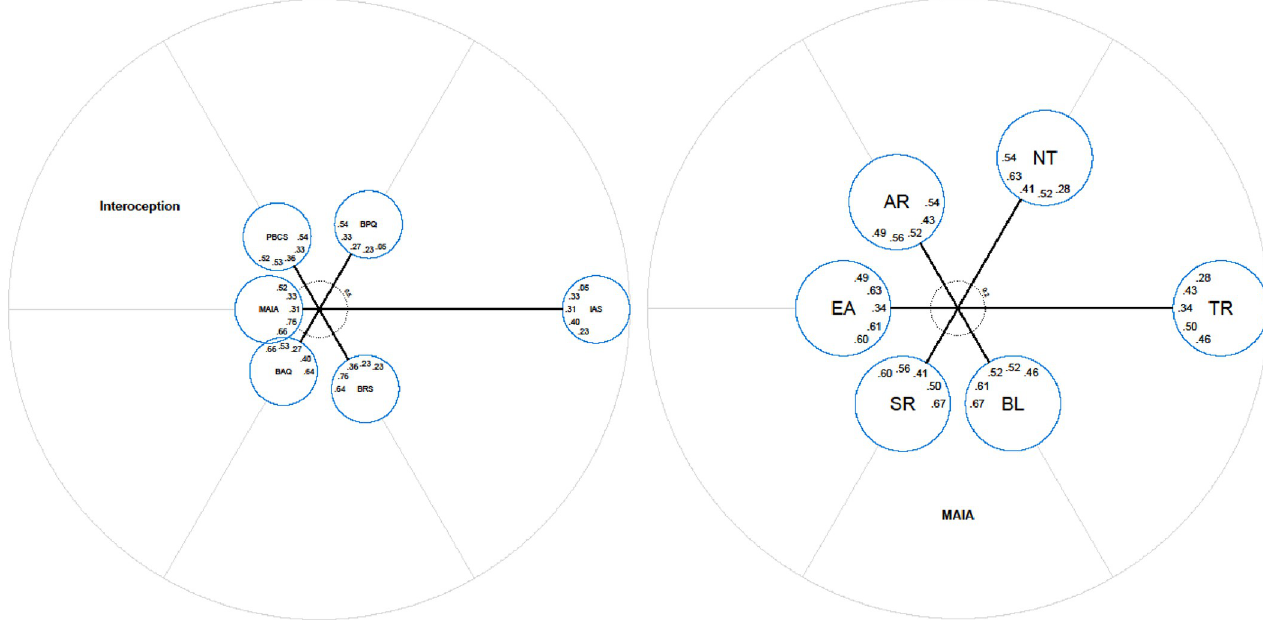
Fig 2. Radar charts with scale locations of all interoceptive sensibility measures (left) including a zoomed chart of the centre, and MAIA-2 subscales in isolation (right). Numbers within the circles represent latent correlations between the respective scale with all the other scales. Correlations are arranged clockwise using the same order as the scales. AR = Attention Regulation, NT = Noticing, TR = Trusting, BL = Body Listening, SR = Self-Regulation, EA = Emotional Awareness.